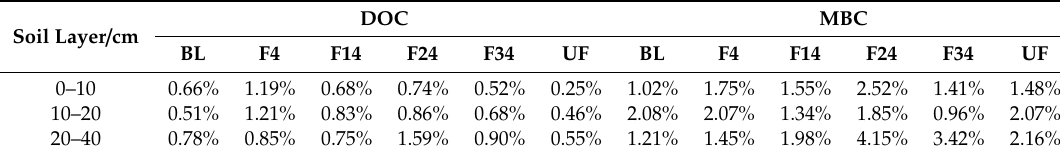
Table 5. The ratios of w (DOC) and w (MBC) to w (TOC) (%). DOC MBC Soil Layer / cm